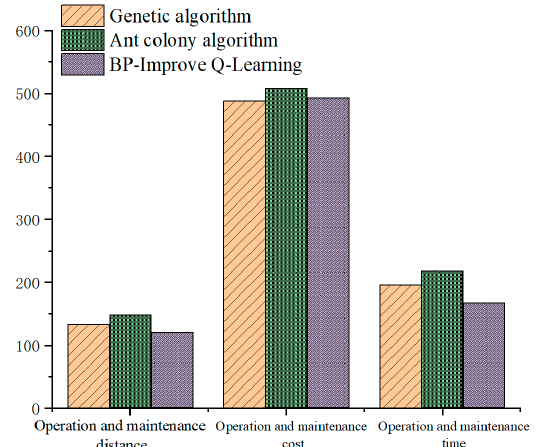
Figure 10. Comparison of example verification.